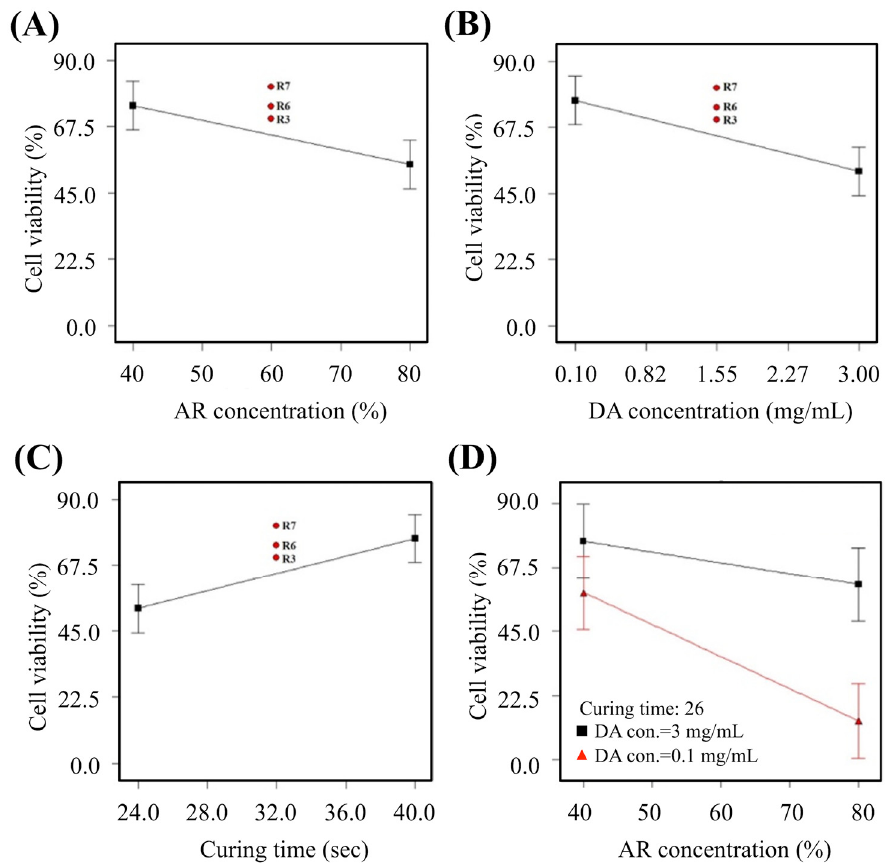
Figure 5. The main effect of ( A ) AR concentration, ( B ) DA concentration, ( C ) curing time, and ( D ) AR-curing time-DA interaction on the cell viability.